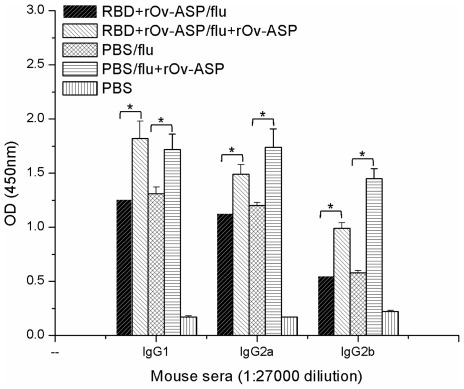
Anti- HAs antibody responses in vaccinated mice.Antibody responses to HAs in mice vaccinated previously with rRBD in combination with the rOv-ASP-1 adjuvant were compared to those generated in mice after primary immunization with the HA vaccine in the presence or absence of the rOv-ASP-1 adjuvant. The IgG isotype responses in individual mouse against influenza virus HAs from three virus strains were tested by ELISA at 1∶27,000 dilutions. * indicates significant difference (p<0.05) among multiple comparisons; in particular between mice that were immunized in the presence of rOv-ASP-1 vs. no adjuvant.